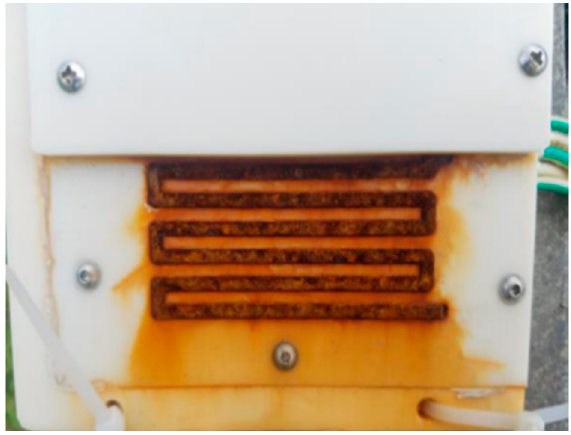
Figure 5. Picture of electrical resistance sensors after the experiment (exposed 99 days).